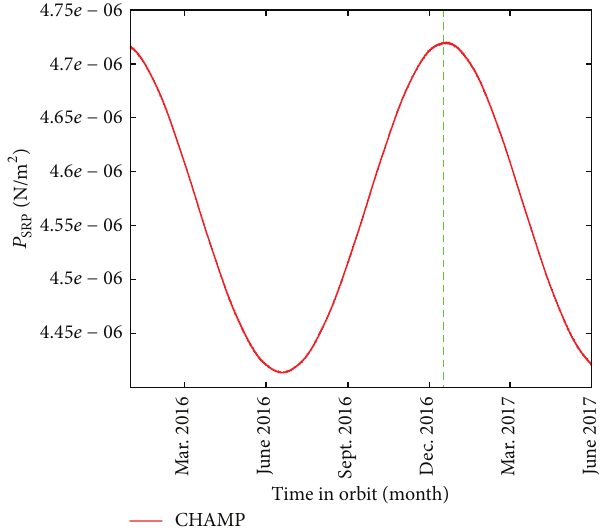
Figure 1: Annual variation of the SRP for satellites orbiting the Earth. Exemplarily, the orbit of CHAMP is depicted.